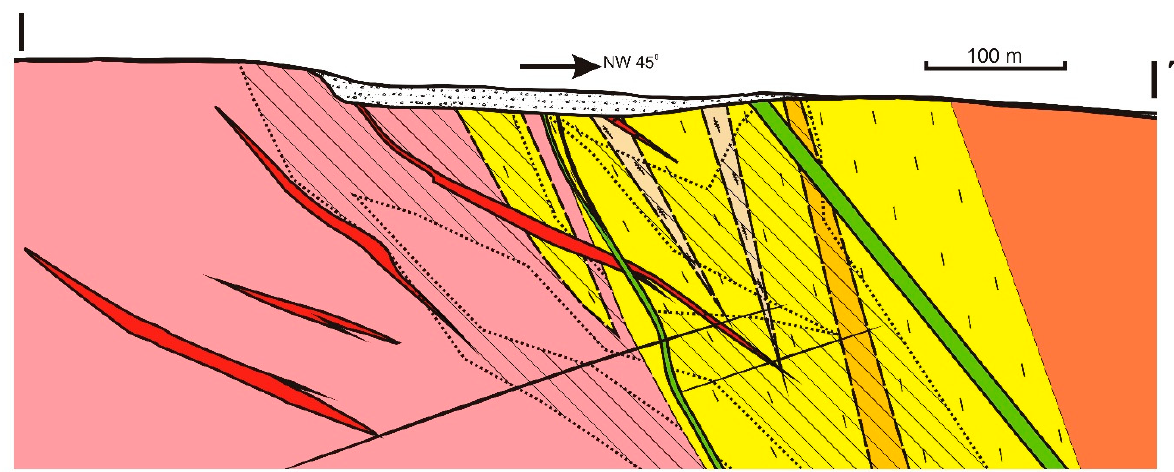
Figure 4. Cross-section of the mineralized stockwork of the Pellapahk Cu-Mo deposit along I–I’ line, modified from refer- ence [9]. See Figure 2 for Legend.